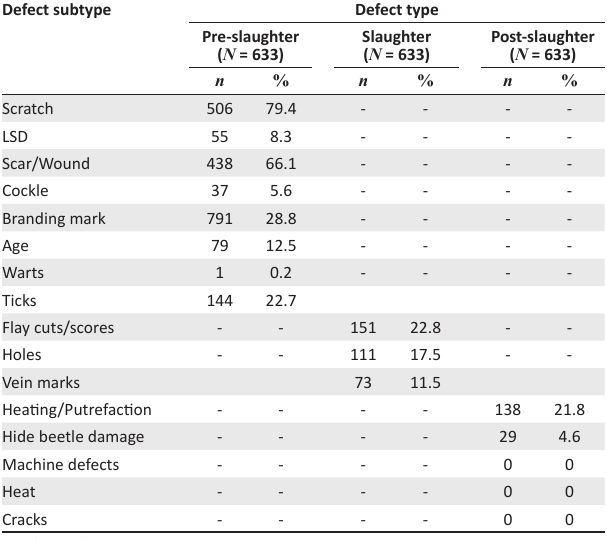
TABLE 3: Pre-slaughter, slaughter and post-slaughter defects of wet blue hides from cattle in the Tigray region, Ethiopia. Defect